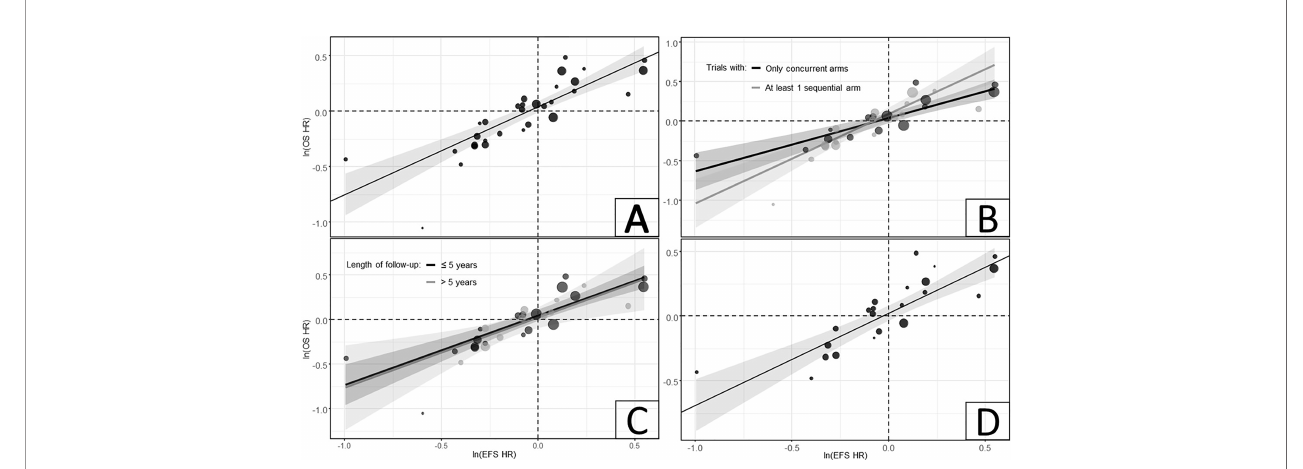
FIGURE 2 | Relationship between ln(HRs) of EFS and OS in (A) all CRT trials; (B) Model with interaction term for timing of CRT; (C) Model with interaction term for length of follow-up duration; and (D) subset of trials with matching EFS de fi nitions, only including death and disease progression as endpoints. CRT was de fi ned as the combination of RT and any class of systemic therapies, including chemotherapy, targeted therapy or a combination of both. CI, con fi dence interval; CRT, chemoradiation therapy; EFS, event-free survival; HR, hazard ratio; OS, overall